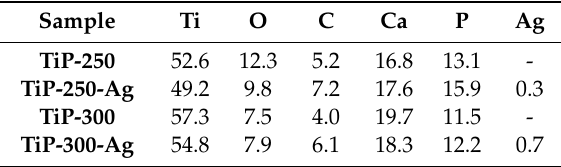
Table 1. The semiquantitative EDX analysis results, wt.%.